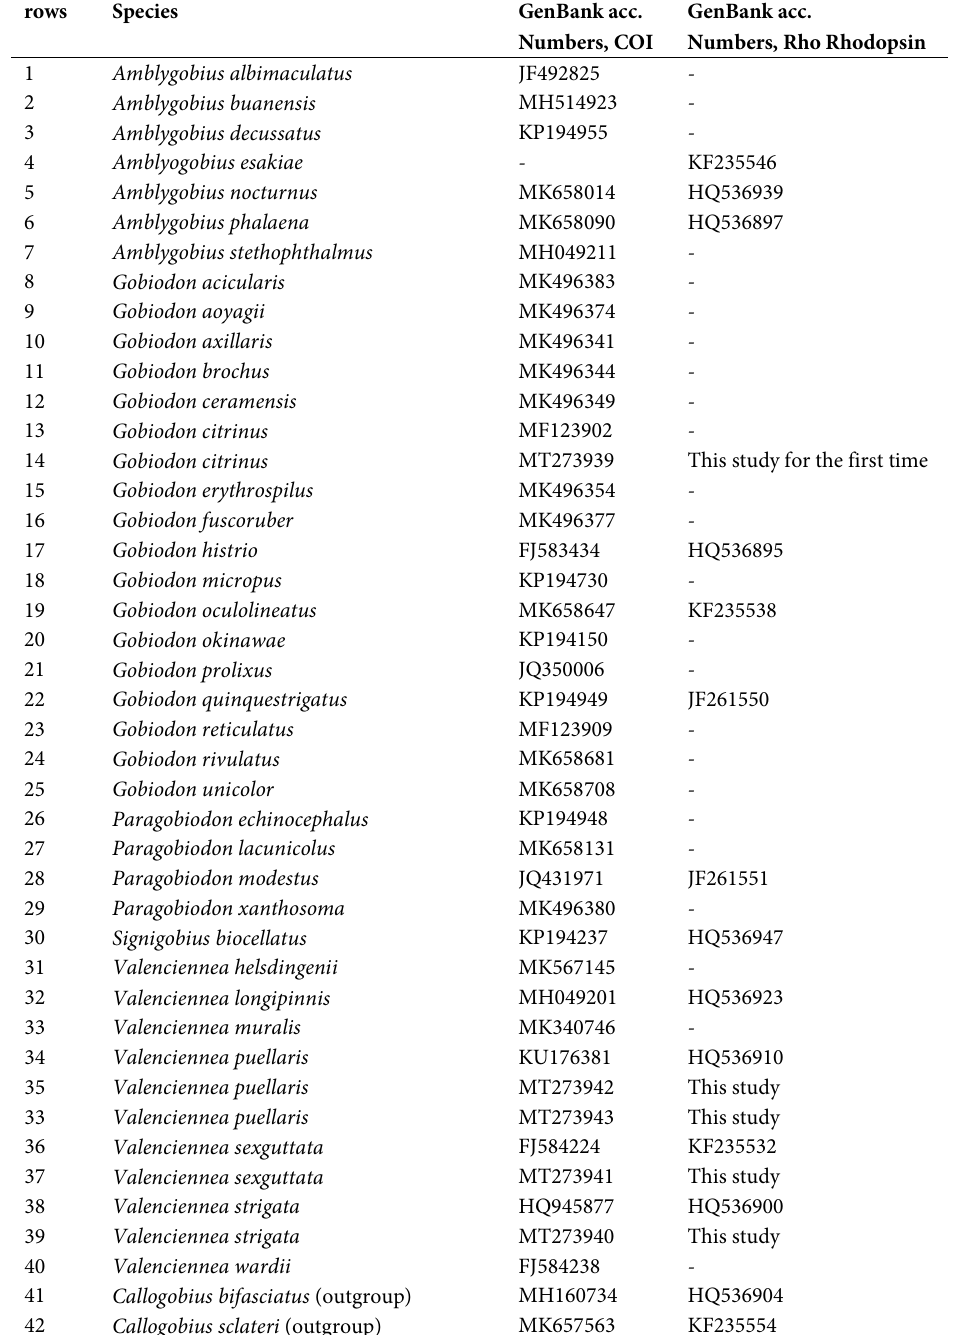
T ABLE 1. Taxa, molecular markers, and GenBank accession numbers of the sequences used in the phylogenetic analyses.